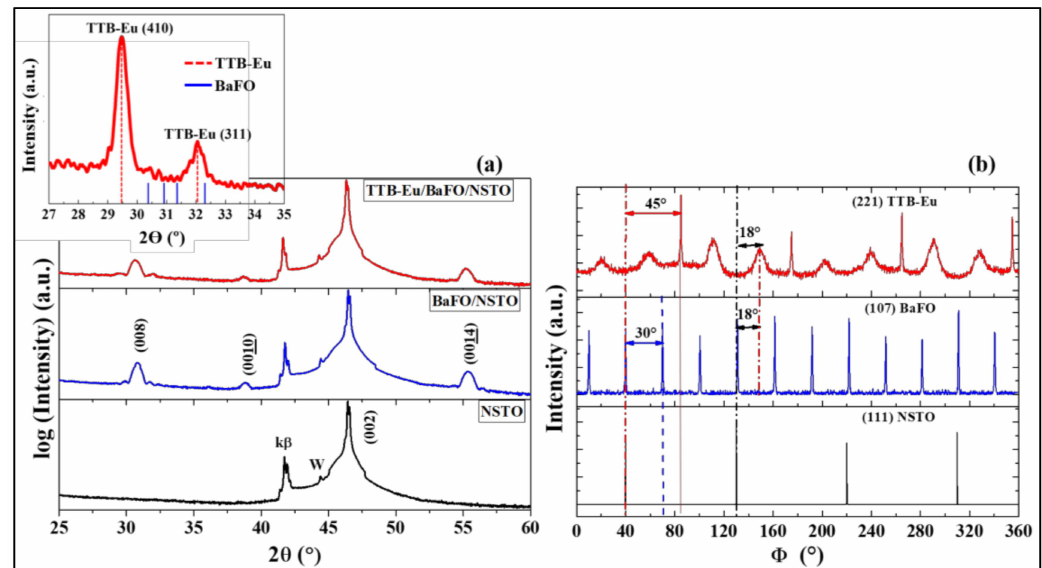
Figure 2. Structural characterization of TTB-Eu/BaFO/NSTO (001) heterostructured films: ( a ) X-ray diffractograms of NSTO substrate, BaFO films and TTB-Eu/BaFO heterostructure; ( b ) Φ -scan mea- surements of the {221} planes of TTB-Eu films, as well as of the {107} planes of the BaFO intermediate magnetic layer and the {111} planes of the single crystalline NSTO (001) substrate. The inset of figure ( a ) shows the in-plane X-ray diffractogram of the heterostructure where the red lines indicate the positions of the TTB-Eu peaks and the blue lines denote the peaks positions of the BaFO phase, allowing the characterization of the crystallization and the orientation of the TTB-Eu